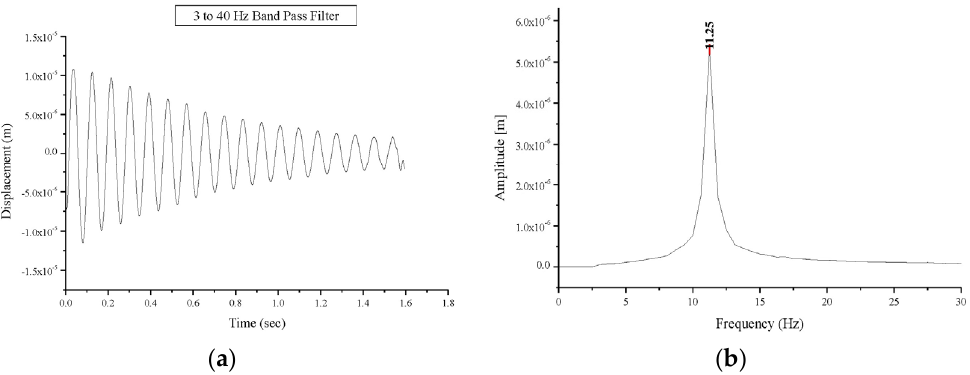
Figure 7. Free oscillations response of the undamaged vault BV1: ( a ) displacement versus time; ( b ) Fourier transform: amplitude versus frequency.